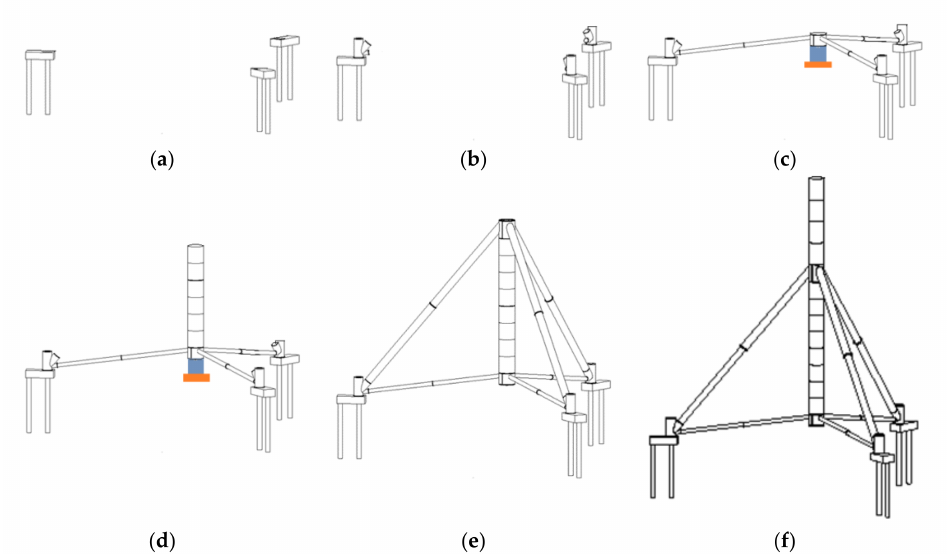
Figure 9. Successive steps of the erection methodology ( a ) construction of foundation; ( b ) anchoring of corner junction pieces; ( c ) placement of temporary support structure and connection of lower in- clined legs; ( d ) connection of successive parts of vertical leg; ( e ) connection of upper inclined legs and removal of temporary support structure; ( f ) connection of successive parts of tubular